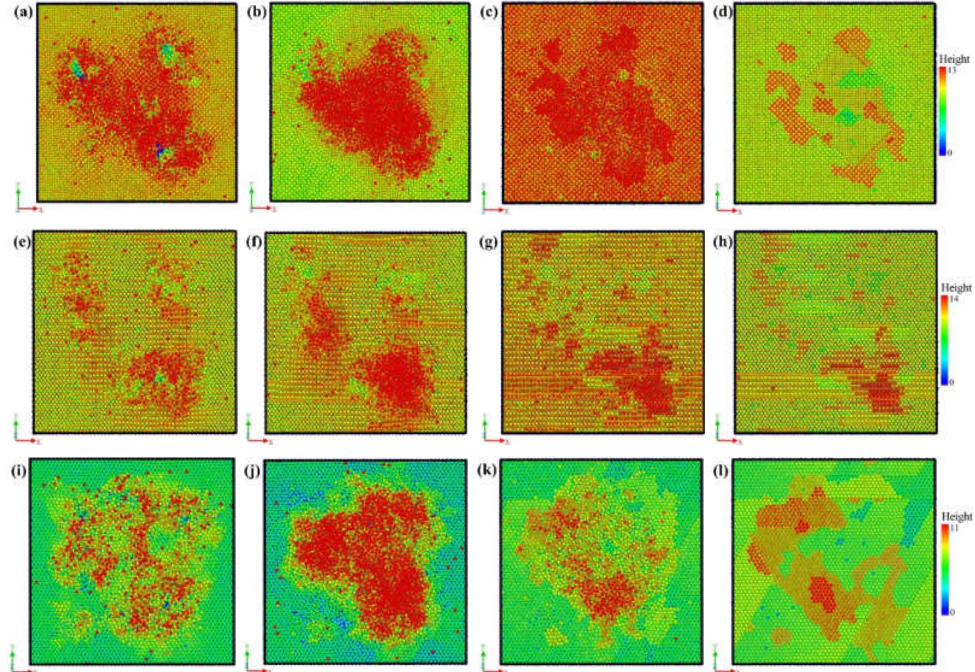
Figure 7. Surface morphology evolution of aluminum crystal surface of; Al(001) ( a ) 6 ps, ( b ) 9 ps, ( c ) 28 ps, ( d ) 100 ps; Al(110) ( e ) 6 ps, ( f ) 9 ps, ( g ) 28 ps, ( h ) 100 ps; Al(111) ( i ) 6 ps, ( j ) 9 ps, ( k ) 28 ps, ( l ) 100 ps.